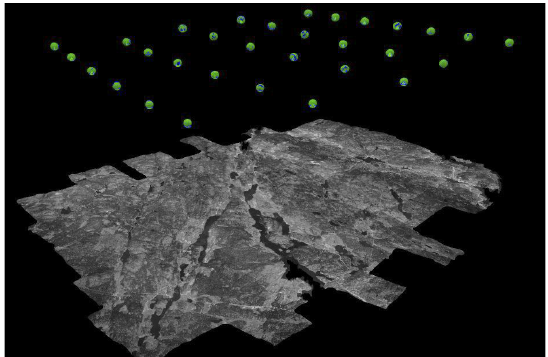
Figure 9. Automatic aerial triangulation and dense image matching results (1 m resolution) for a subset of the Austre